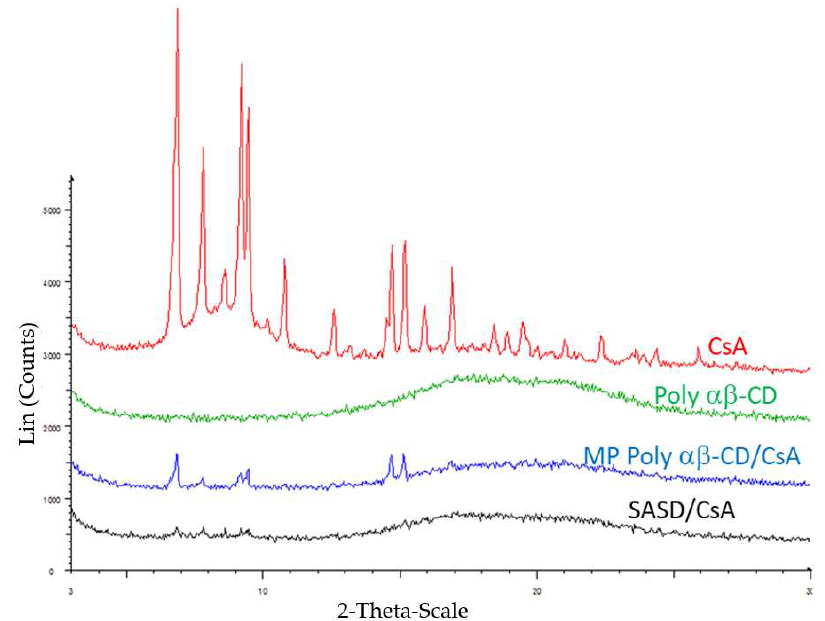
Figure 2. X-ray diffraction patterns of crystalline cyclosporine (CsA), Poly- αβ -CD copolymer, physical mixture of Poly- αβ -CD/CsA, and spherical amorphous solid dispersion based on Poly- αβ -CD copolymer of CsA (SASD/CsA). The curves are illustrated respectively from top to bottom as indicated in the diagram.